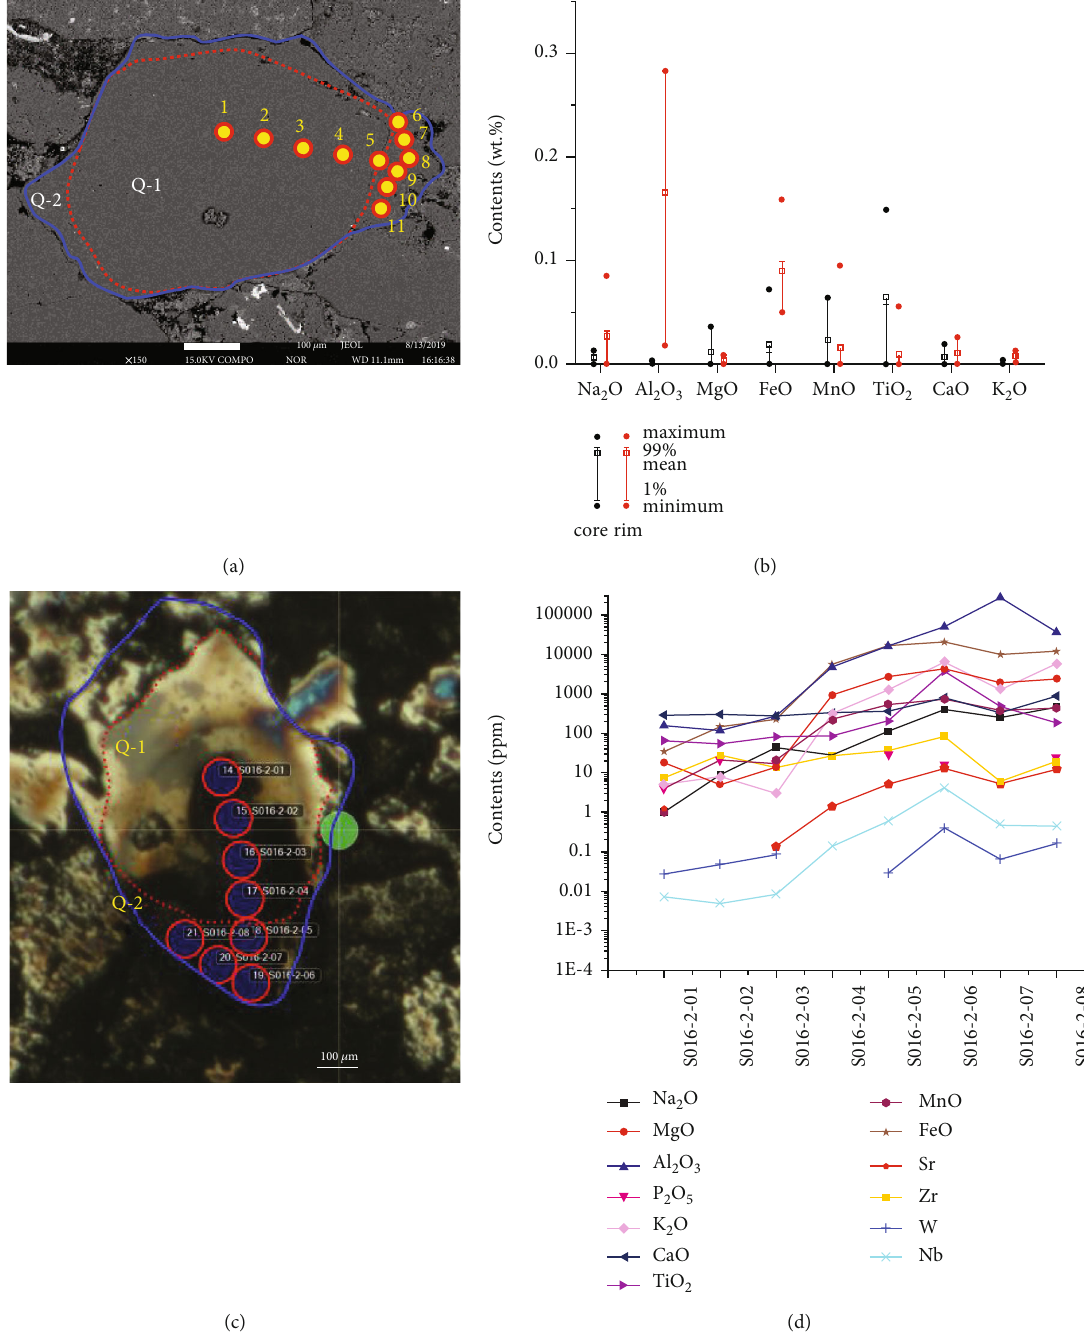
Figure 4: Distribution of electron microprobe analysis points (a) and major element contents (b) in quartz in a sample from well D13. (c, d) The distribution of LA-ICP-MS analysis points and major and trace element contents in quartz in the same sample (sample S016, 4209m depth). Q-1=core of the quartz grain; Q-2=quartz